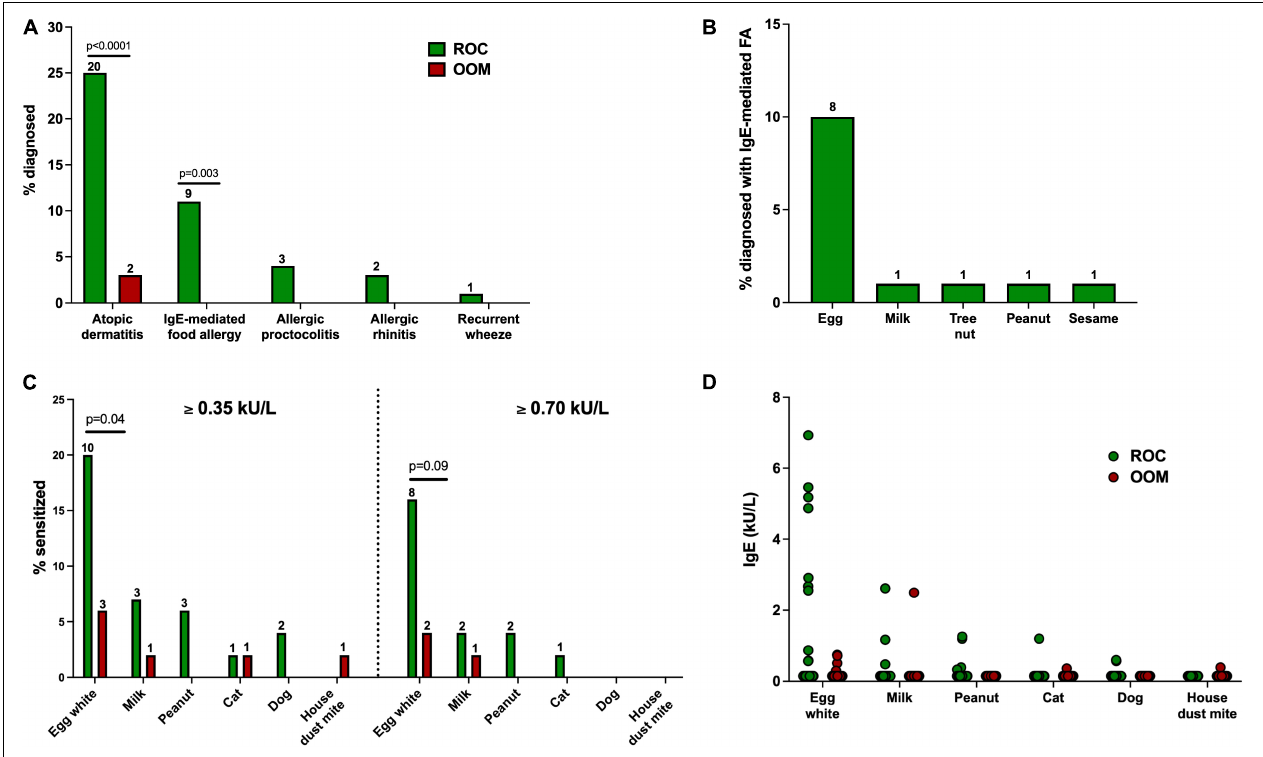
FIGURE 3 | Atopic disease outcomes and sensitization at 12 months of age. Numbers on top of bars in (A–C) refer to the absolute number of children represented. (A) Proportion of ROC and OOM children with physician-diagnosed allergic diseases. (B) Proportion of ROC children diagnosed with IgE-mediated FA. No OOM children were diagnosed with FA. (C) Proportion of ROC ( n = 46–49) and OOM ( n = 50) children with sensitization to select food and aeroallergens measured by ImmunoCAP using two different cutoffs ( ≥ 0.35 kU/L and ≥ 0.7 kU/L). (D) Specific IgE levels in ROC ( n = 46–49) and OOM ( n = 50) children. Levels not detectable are displayed as half of the detection limit (0.15 kU/L). For categorical variables, Fisher’s exact test was used to determine statistical significance between OOM and ROC groups. A Mann–Whitney U test was used for continuous variables, which all followed a non-normal distribution as assessed by a Shapiro–Wilk test. ROC, Rochester. OOM, Old Order